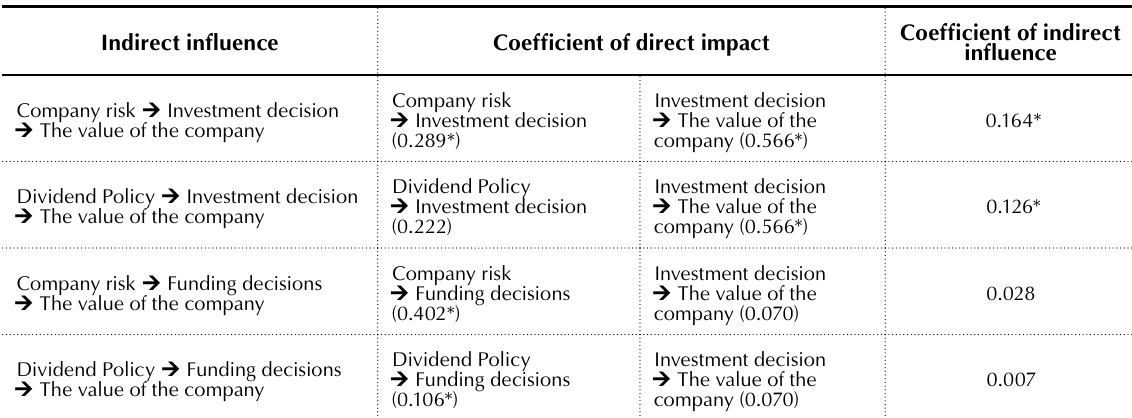
Source: secondary data processed